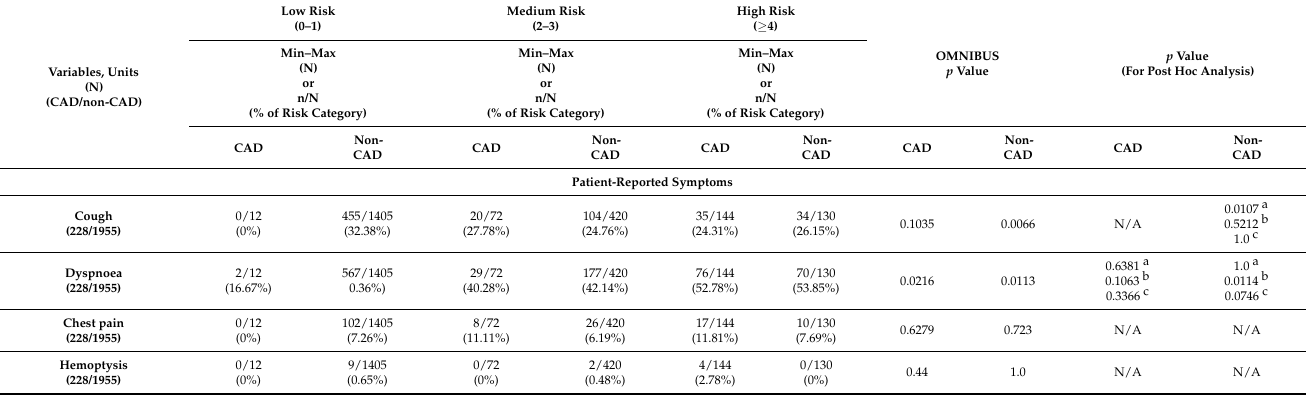
Table 3. Patient-reported symptoms, vital signs and abnormalities measured during physical